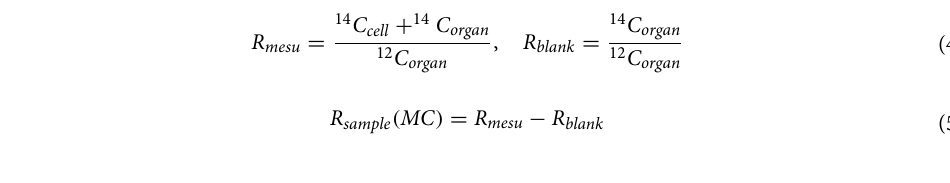
The measurement results of AMS were obtained by the ratio of the amount of 14 C ( 14 C cell and 14 C organ ) and 12 C ( 12 C organ ) as shown in the following equation Eq. (4). R mesu and R blank are the value of 14 C/ 12 C of the sample and pre-dose organ, respectively. 12 C organ is the amounts of carbon ( 12 C) contained in the prepared organ. R sample was calculated by subtracting R mesu from R blank , Eq. (5).